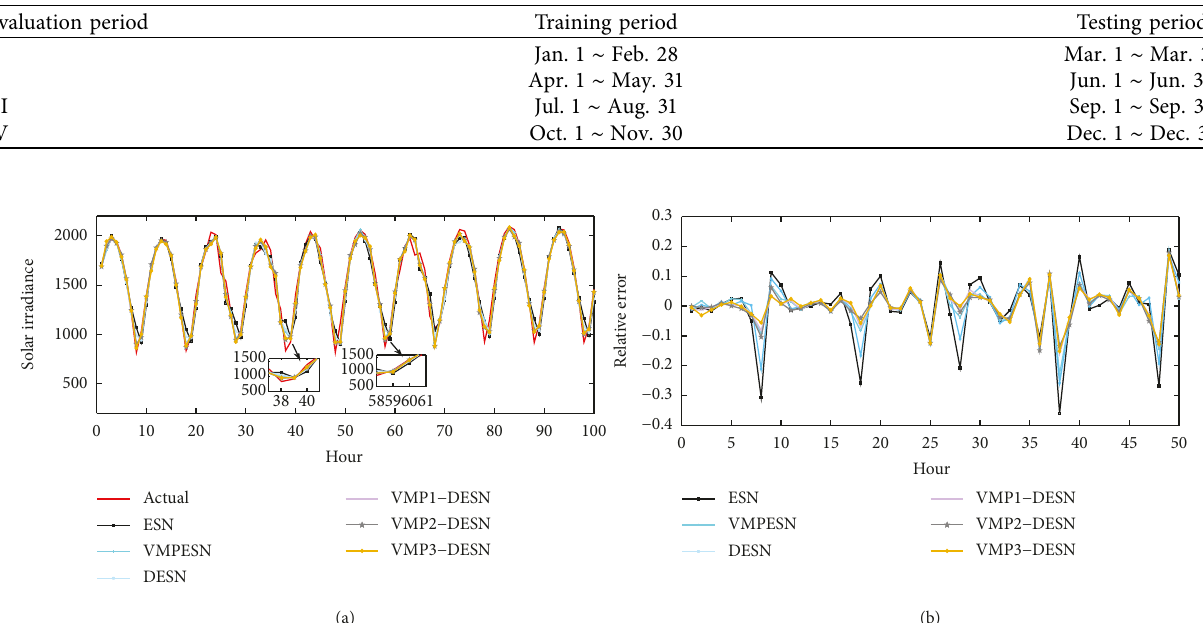
Figure 2: (a) The actual values versus predicted solar irradiance by different models. (b) The corresponding relative error comparison. Table 3: RMSE, nRMSE, MAE, and MAPE versus delayed time for evaluation period II at Seeley station.